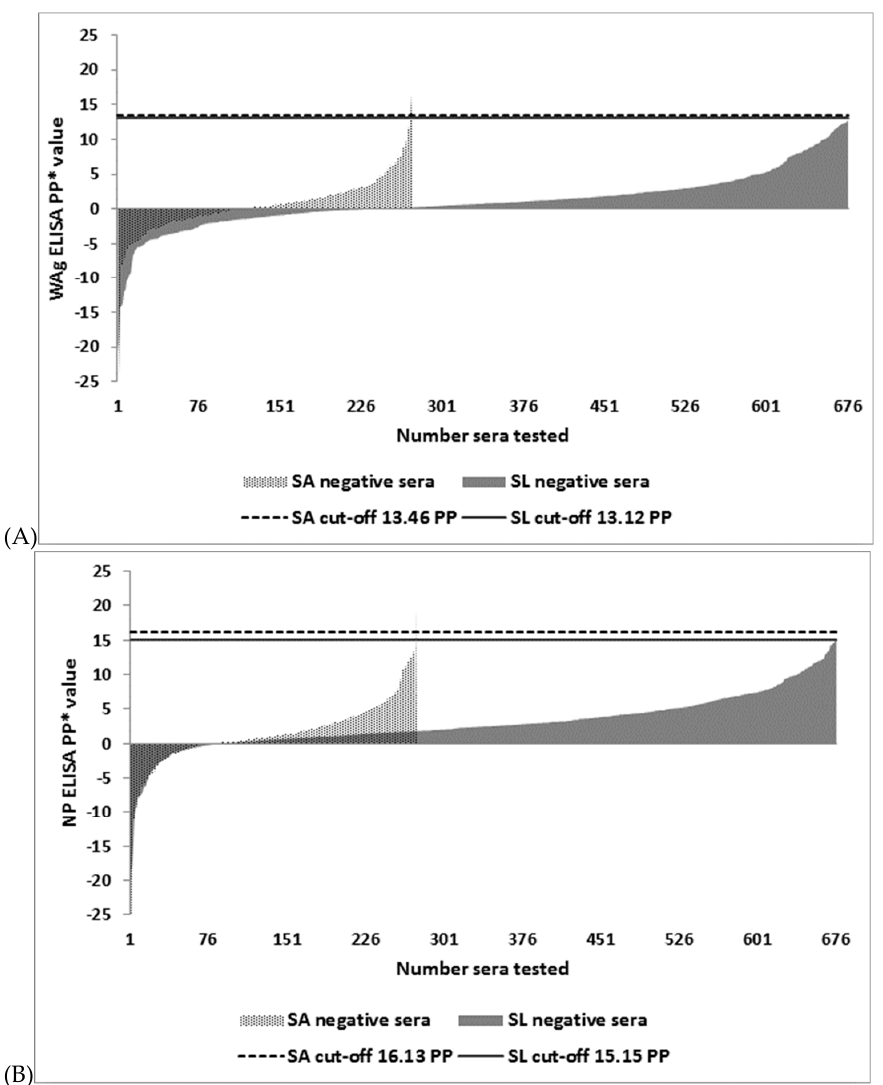
Viruses 2019 , 11 FOR PEER REVIEW